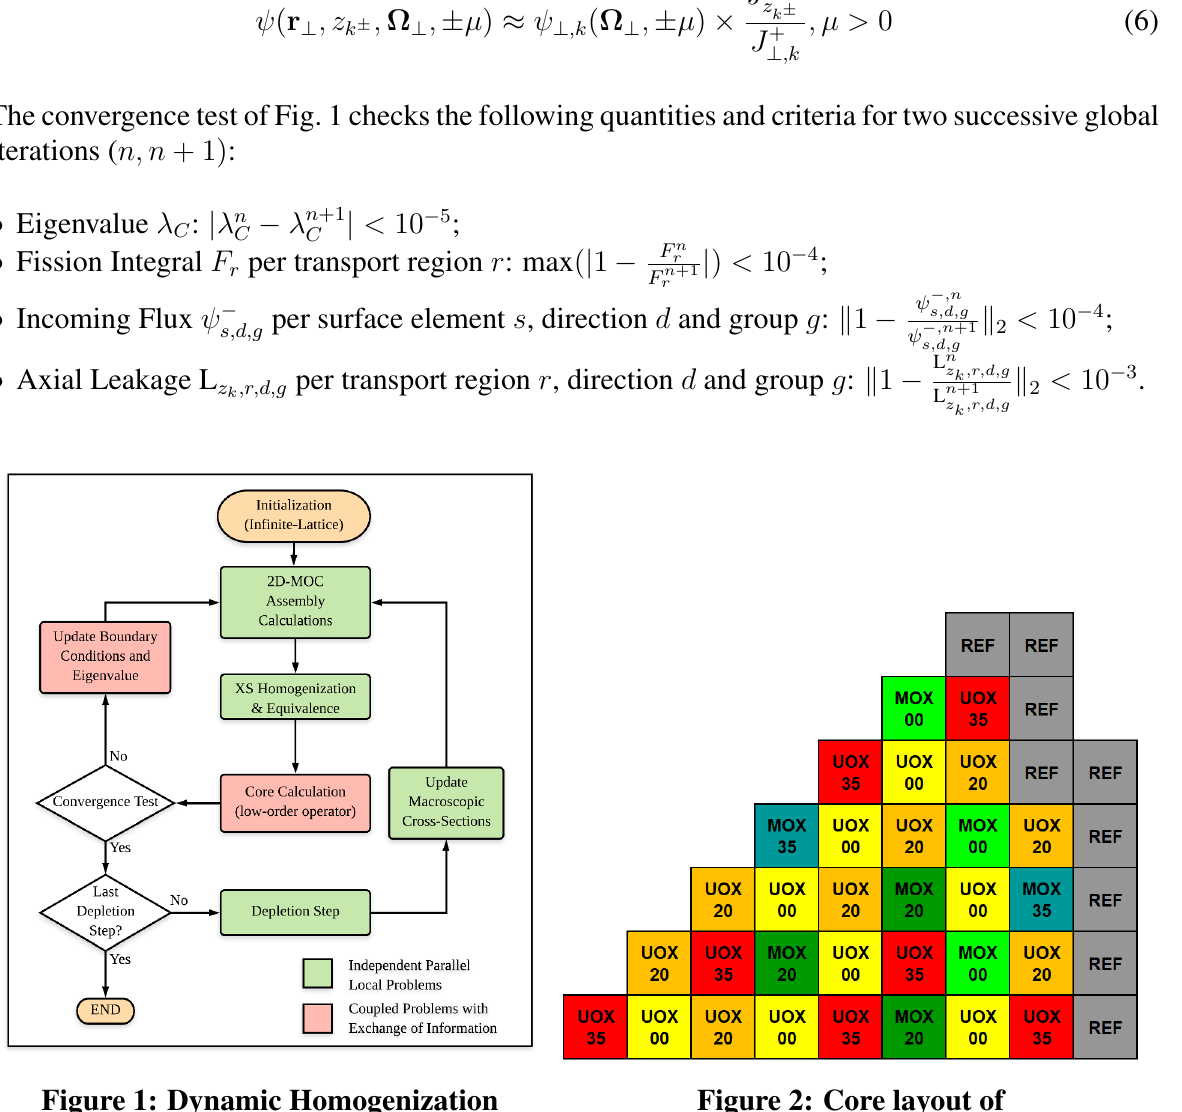
Figure 1: Dynamic Homogenization Figure 2: Core layout of calculation scheme. NEA Benchmark with 1/8 radial symmetry